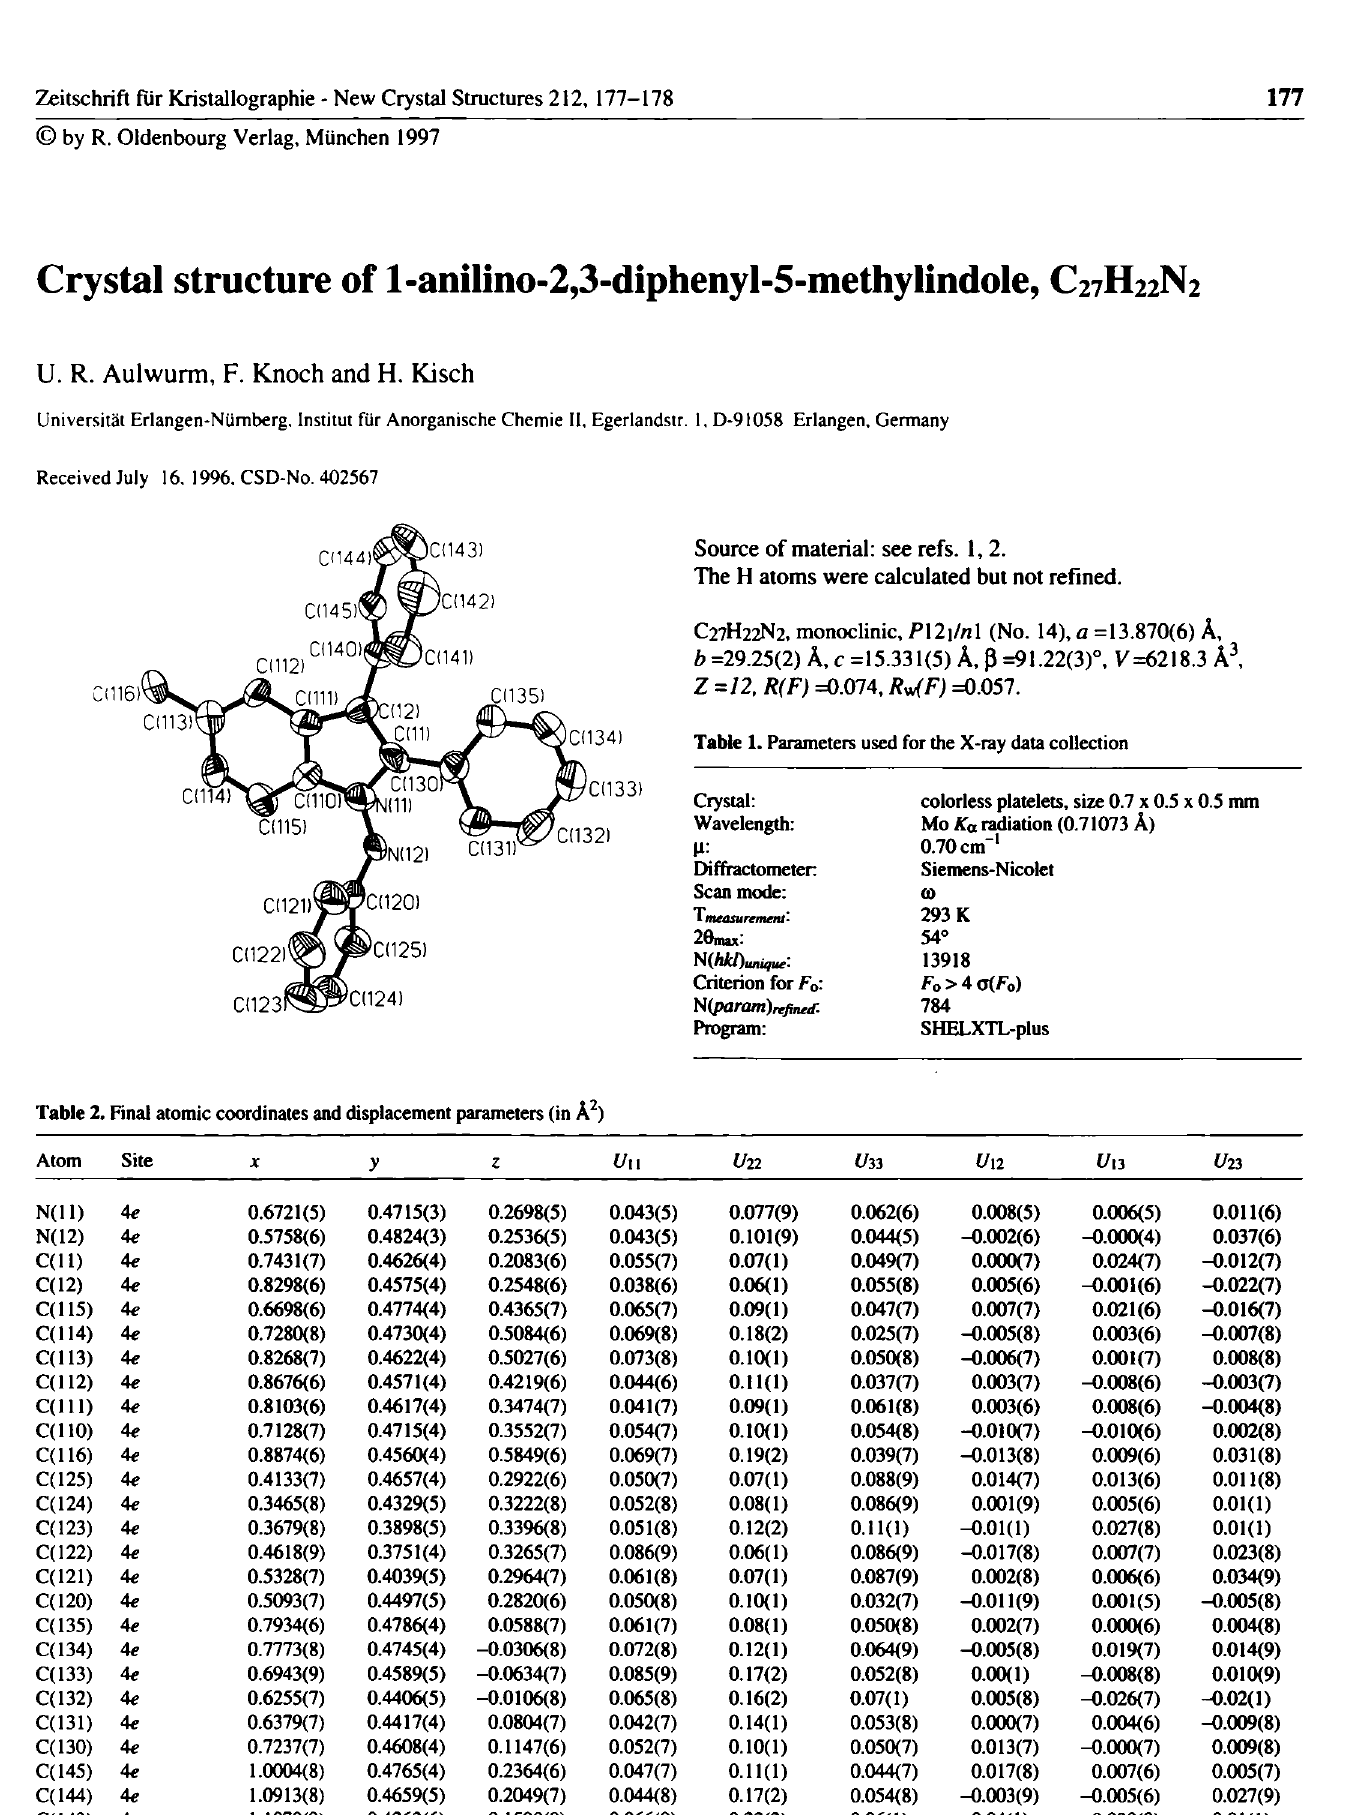
Table 2. Final atomic coordinates and displacement parameters (in Â 2